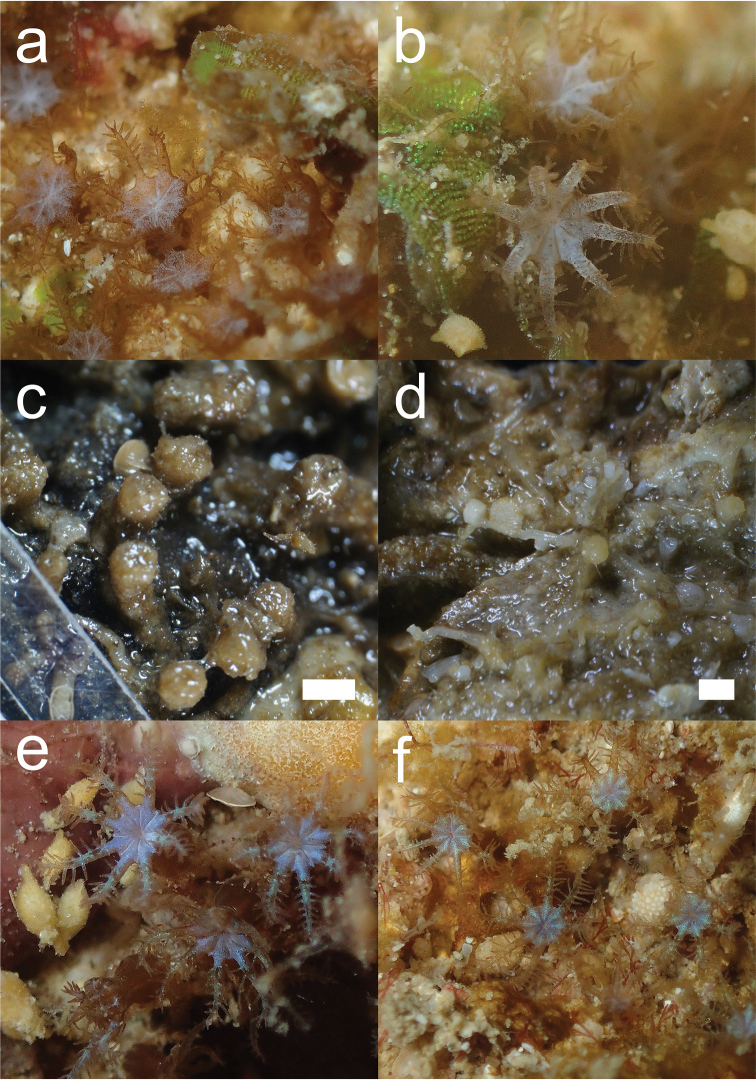
Bunga
payung gen. nov. et sp. nov.: a In situ photograph, holotype (NSMT-Co 1679) b In situ photograph, paratype (IPMB-C 01.00017) c holotype in ethanol. Laeta
waheedae gen. nov. et sp. nov. d holotype (NSMT-Co 1680) in ethanol e In situ photograph, holotype f In situ photograph, paratype (IPMB-C 01.00019). Scale bars: 1 mm.